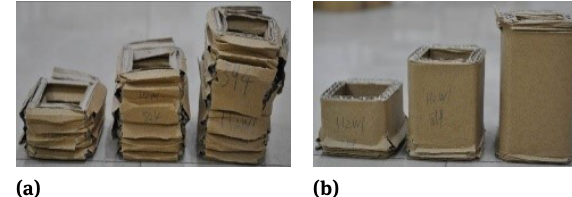
Figure 9: Deformation modes for different tube lengths: (a) X- and (b) Y-direction paper corrugation tubes